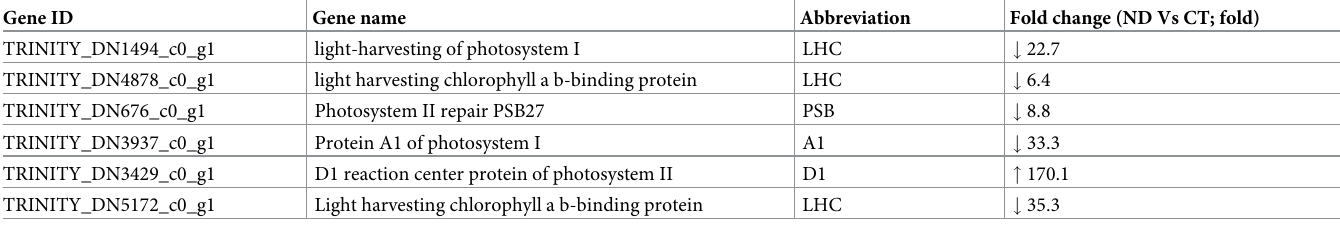
Table 4. Differential gene expression related to photosynthesis in P . cruentum